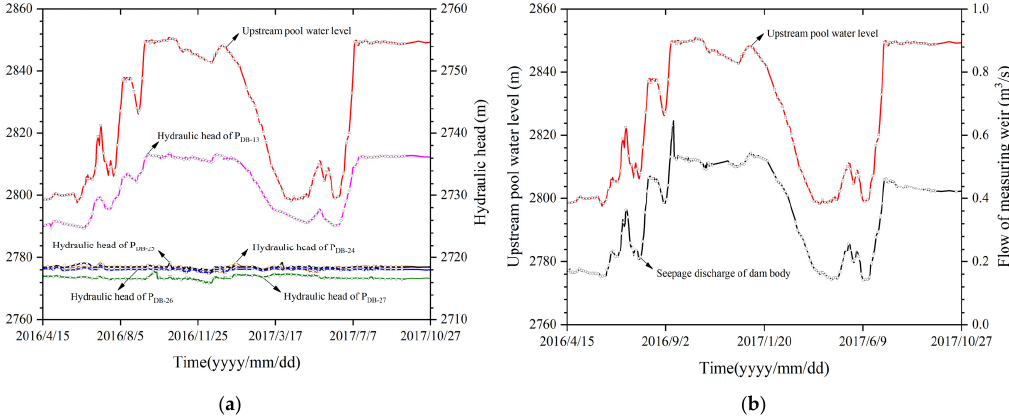
Figure 6. Measurements of hydraulic head and seepage discharge during storage period: ( a ) hydraulic head; ( b ) seepage volume.